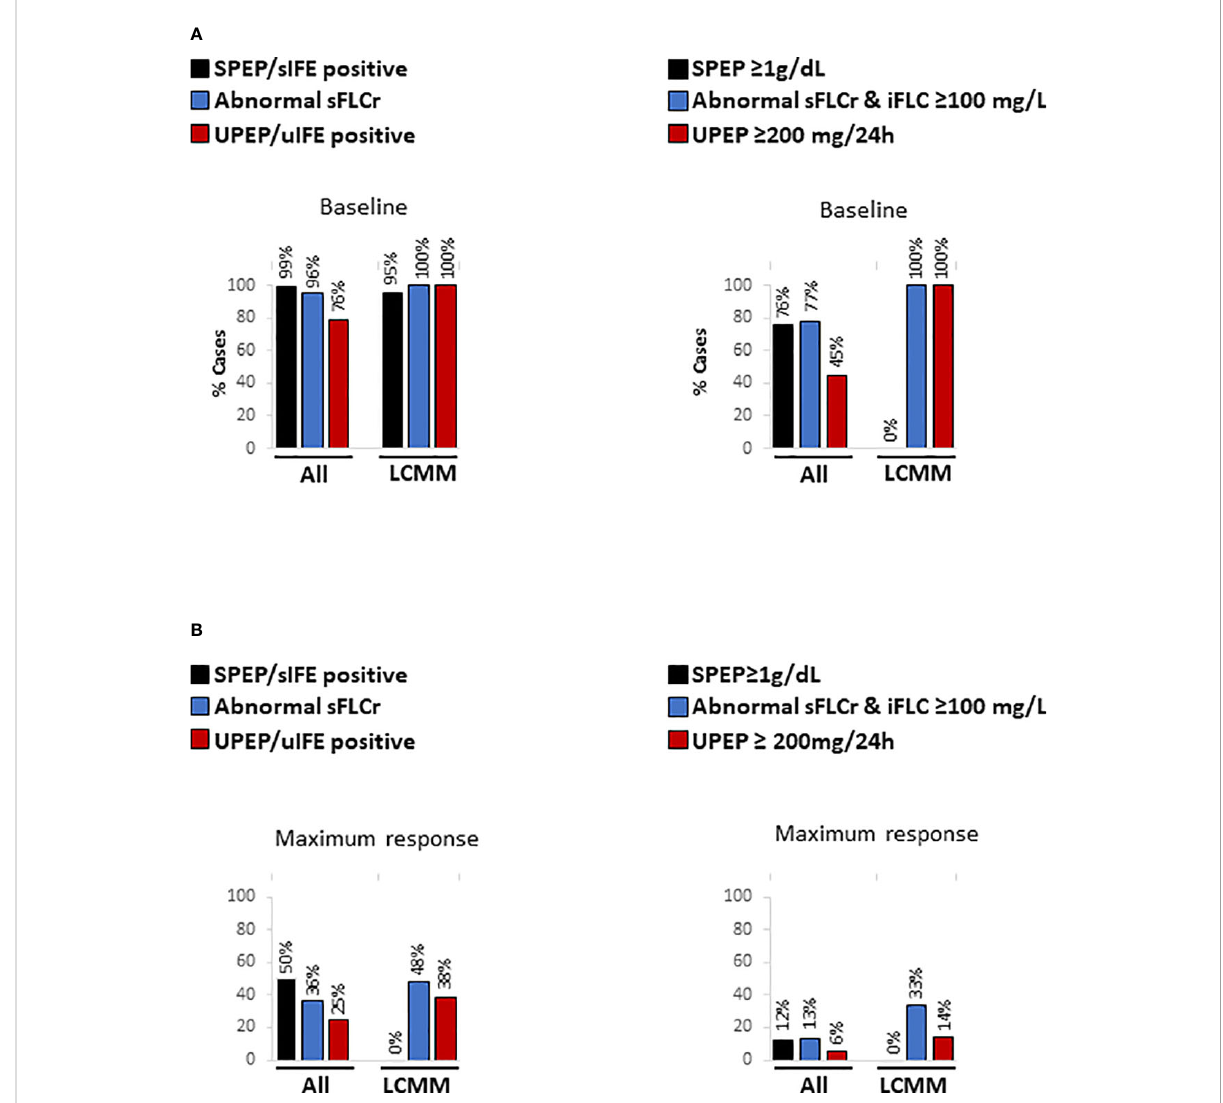
FIGURE 1 Percentage of detectable and measurable disease by SPEP/sIFE, serum FLCs and UPEP/uIFE tests for both, the entire cohort and LCMM patients (A) before starting the fi rst and/or the second line of treatment (baseline) and (B) at time of maximum response. LCMM, light chain multiple myeloma; sFLCr, serum free light chains ratio; sIFE, serum immuno fi xation electrophoresis; SPEP, serum protein electrophoresis; uIFE, urine immuno fi xation electrophoresis; UPEP, urine protein